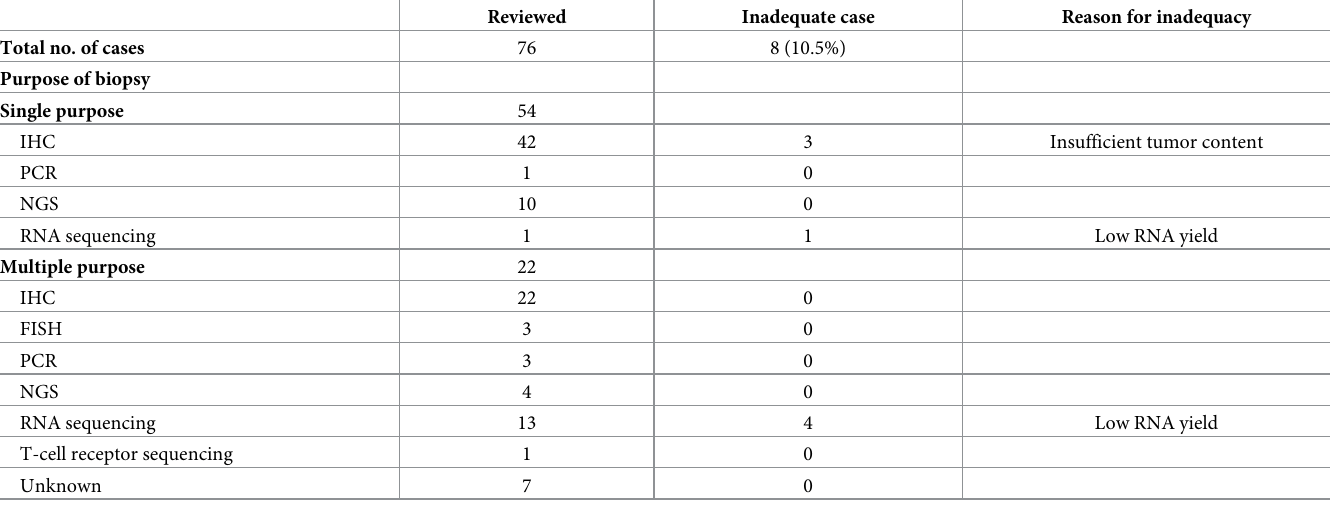
Table 4. Tissue adequacy for pre-planned molecular test.